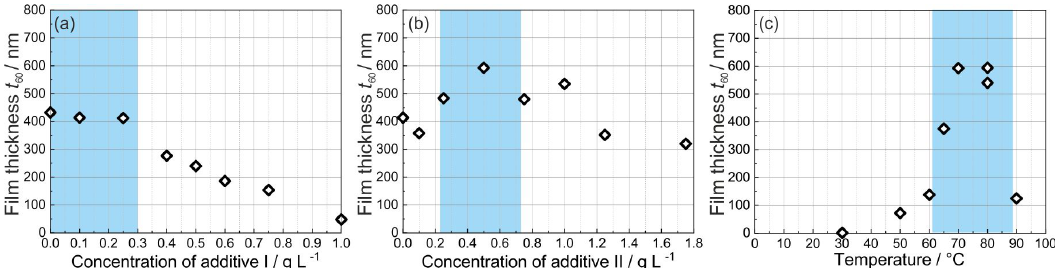
Figure 2. Film thickness t 60 after 60 min of deposition for various additive concentrations on thermally oxidized Si (100) substrates (100 nm W adhesion layer with 10 nm Pt seed layer): ( a ) variation